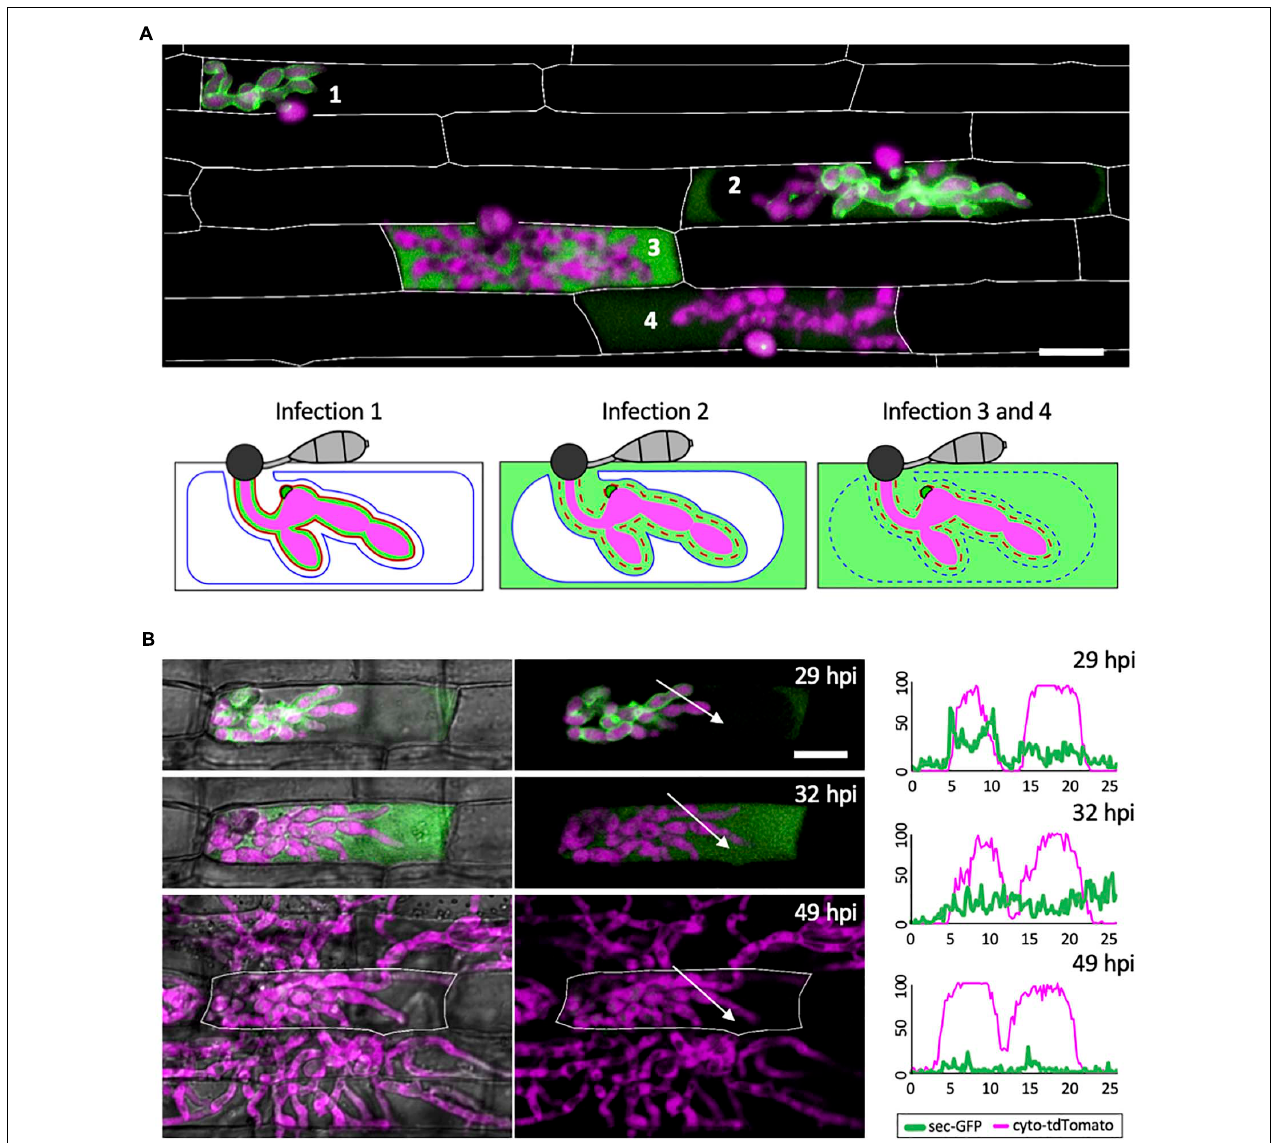
FIGURE 2 | The EIHM loses integrity during invasion of the first host cell. (A) A merged fluorescence projection of M. oryzae CKF1996, expressing sec-GFP (green) and cytoplasmic tdTomato (magenta) in first-invaded rice cells at 32 hpi. Infections are representative of the patterns observed for sec-GFP localization: retention within the EIHMx (infection 1), spilled into the rice cytoplasm with exclusion from the vacuole (infection 2), and spilled homogenously into the rice cell lumen with a ruptured vacuole (infection 3 and 4). Rice cell walls are denoted by white outlines. The same three sec-GFP patterns are schematically illustrated with the addition of the EIHM membrane (red line) and the vacuole membrane (blue line). Disrupted membranes are indicated by a dotted line. Bar = 20 µ m. (B) Shown are merged fluorescence and bright-field (left) and merged fluorescence alone (right) of a time-lapsed CKF1996 infection from 29 to 49 hpi. At 29 hpi, sec-GFP fluorescence (green) was partially spilled from the EIHMx into the rice cytoplasm and excluded from the vacuole. Three hours later, all sec-GFP fluorescence was homogenously distributed throughout the rice cell. After another 17 h, viable IH (magenta) had exited the first-invaded host cell (white outline) and had successfully invaded and colonized multiple adjacent rice cells. White arrows denote the locations used for generating the fluorescence intensity linescans. Bar = 20 µ m. The linescans measure the relative fluorescence intensity of sec-GFP (green) and cytoplasmic tdTomato (magenta). At 29 hpi, two neighboring hyphae have different localization patterns of sec-GFP; one hypha is outlined by sec-GFP fluorescence (represented by the two green fluorescence peaks) while the other hypha does not show sec-GFP outlining. At 32 hpi, the same two hyphae both now lacked sec-GFP outlining. At 49 hpi, the same IH did not show significant sec-GFP fluorescence. Units are relative fluorescence units (RFU; y-axis) and distance in µ m (x-axis).